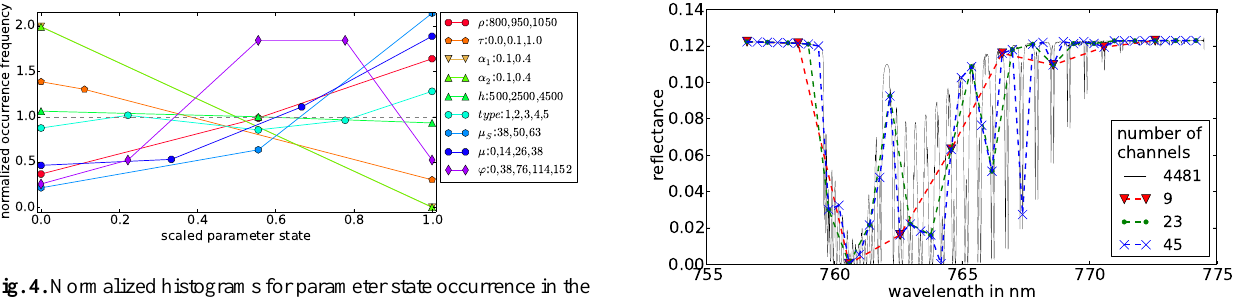
Fig. 4. Normalized histograms for parameter state occurrence in the lowest 10% fraction of a reconstruction SNR data set based on 500 samples. The occurring states are scaled to a range of [ 0 , 1 ] such that Fig. 5. The grey line shows an example spectrum from the lookup they can be shown on the same axes. The corresponding values are table. The red, green and blue lines are the result if only every 500th, Fig. 5. The grey line shows an example spectrum from the lookup table. The red,green and blue lines are shown in the legend. The occurrences are normalized by the sample 200th, or 100th channel of the original spectrum is considered. the result if only every 500 th, 200 th, or 100 th channel of the original spectrum is considered. size and multiplied by the number of unique parameter values (e.g., three for surface pressure and five for the aerosol type). A value of one indicates equal representation of this particular parameter value within the data set, while larger and smaller values represent over- and under-representation.